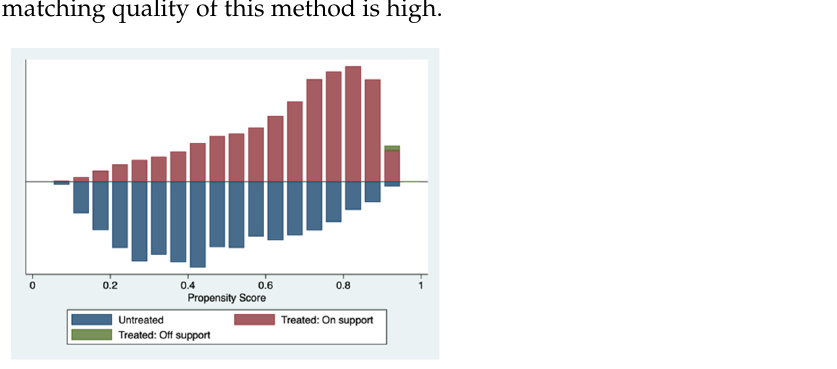
Figure 2. Common value range.